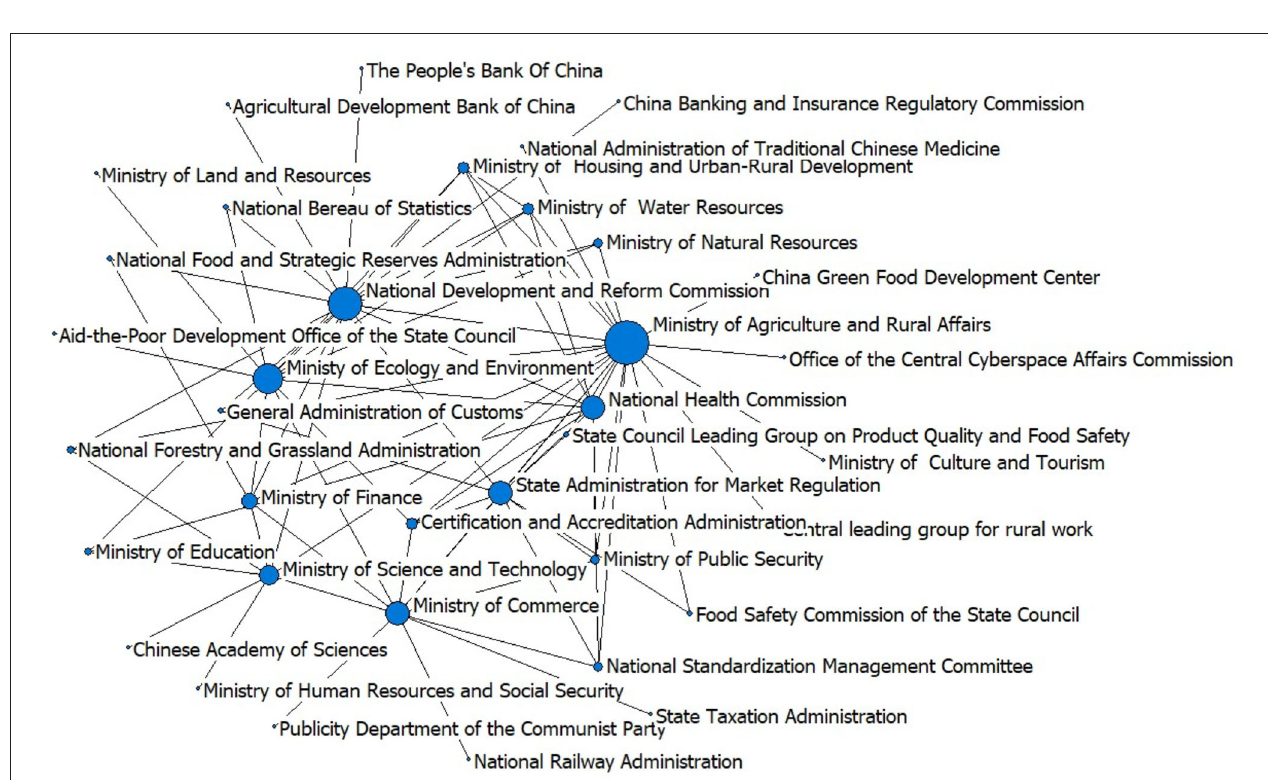
FIGURE 8 | The number of policies involving the pollution-induced food safety issue.